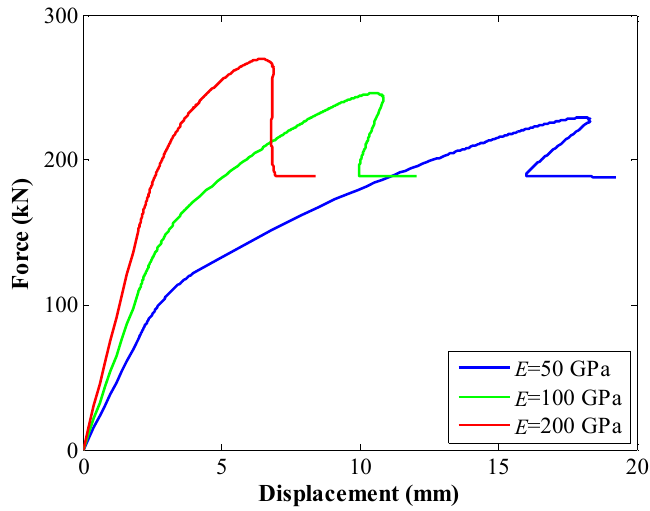
Figure 6. Effect of the modulus of the bars on the load-carrying force. Thirdly, the modulus of the bars significantly influenced the loading displacement where the maximum force of the bars was reached. For example, when bars with a modulus of 50 GPa were tested, the loading displacement at the peak force was 18.1 mm. When the modulus of the bars grew to 100 GPa, the loading displacement at the peak force dropped to 10.6 mm. When bars with a modulus of 200 GPa were tested, the loading displacement dropped to 6.49 mm. Therefore, the loading displacement at the peak force significantly dropped with the modulus of the bars. Lastly, the modulus of the bars influenced the post-peak performance of the bars. When the modulus of the bars was 50 GPa, after the peak load, there was a gradual drop in the load-carrying force. By contrast, when the modulus of the bars grew to 200 GPa, after the peak force, the load-carrying force dropped